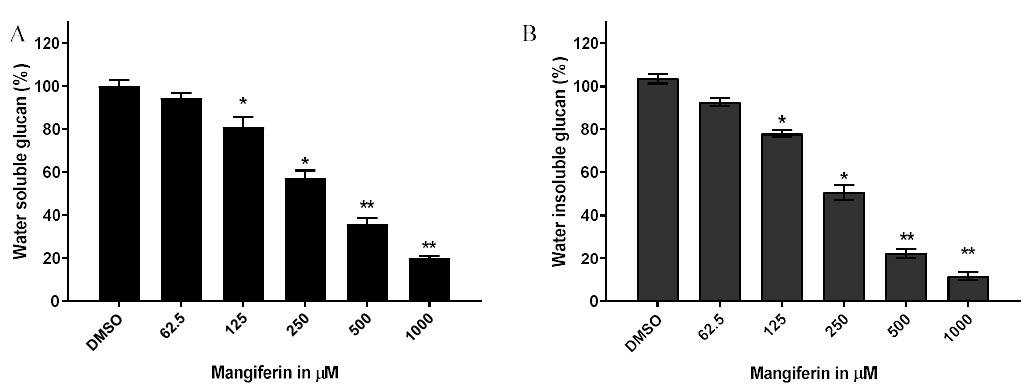
Figure 5. E ff ect of mangiferin on glucan synthesis in S. mutans . ( A ) Water soluble glucan; ( B ) Water insoluble glucan. Data are means ± standard deviations (SD) (n = 3). * p < 0.05, and ** p < 0.001 represent statistical significant di ff erences from the control group.